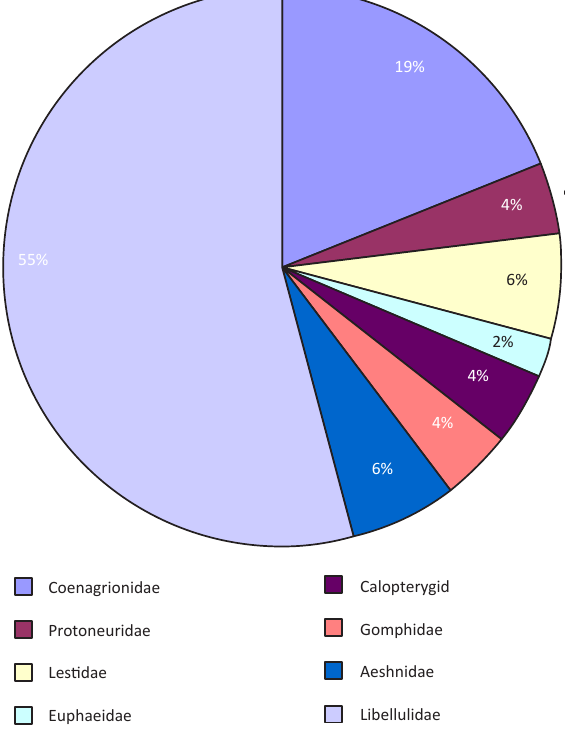
Figure 1. Percentage of species from each family